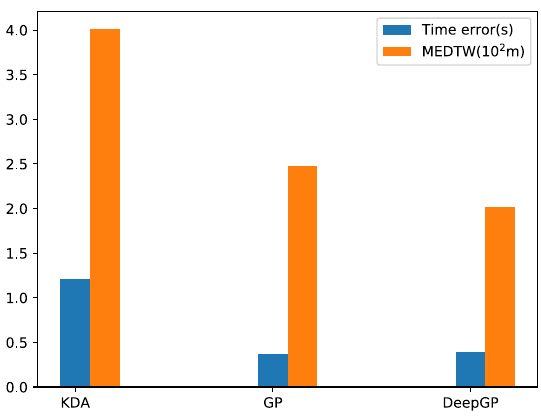
Figure 12. Experimental results for a descent flight.